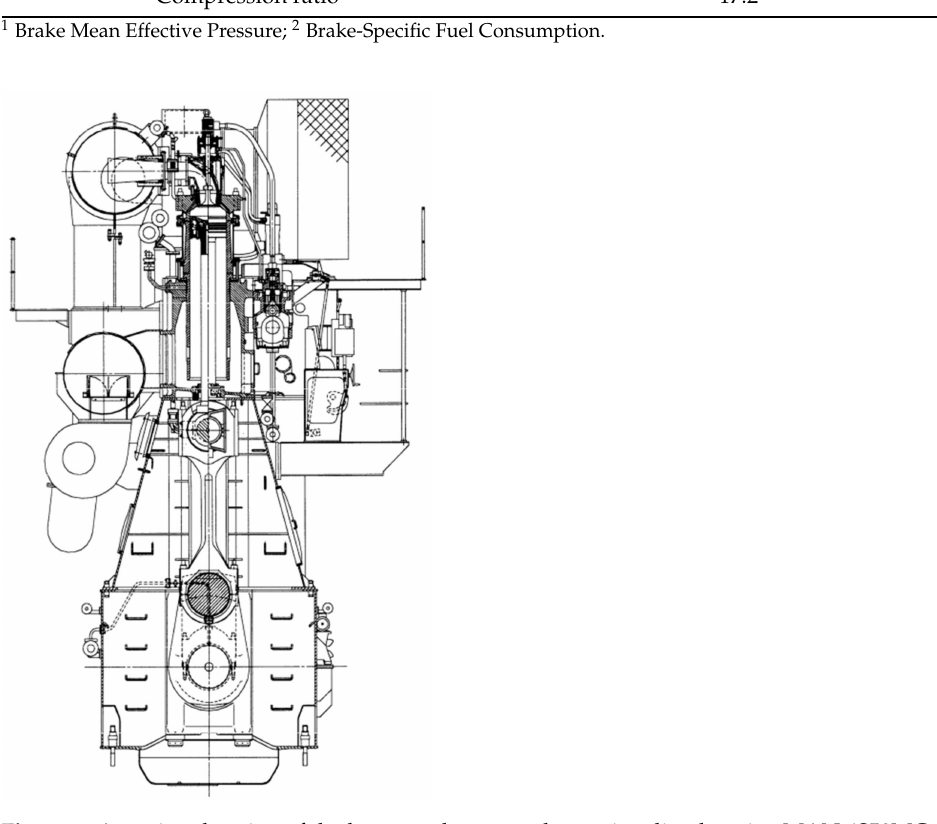
Figure 1. A section drawing of the low speed, two-stroke marine diesel engine MAN